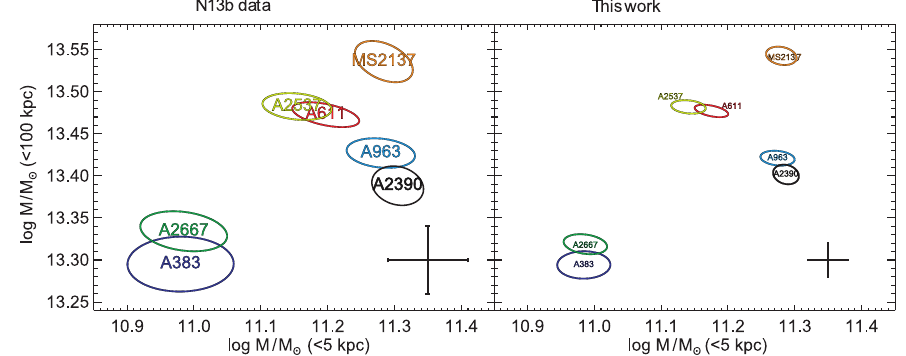
Fig. 3. The mass contained in r < 100 kpc vs. the mass within 5 kpc. The error ellipses are for the 1 (cid:27) uncertainty. The left panel refers to the N13a data and the right panel { to the results of this